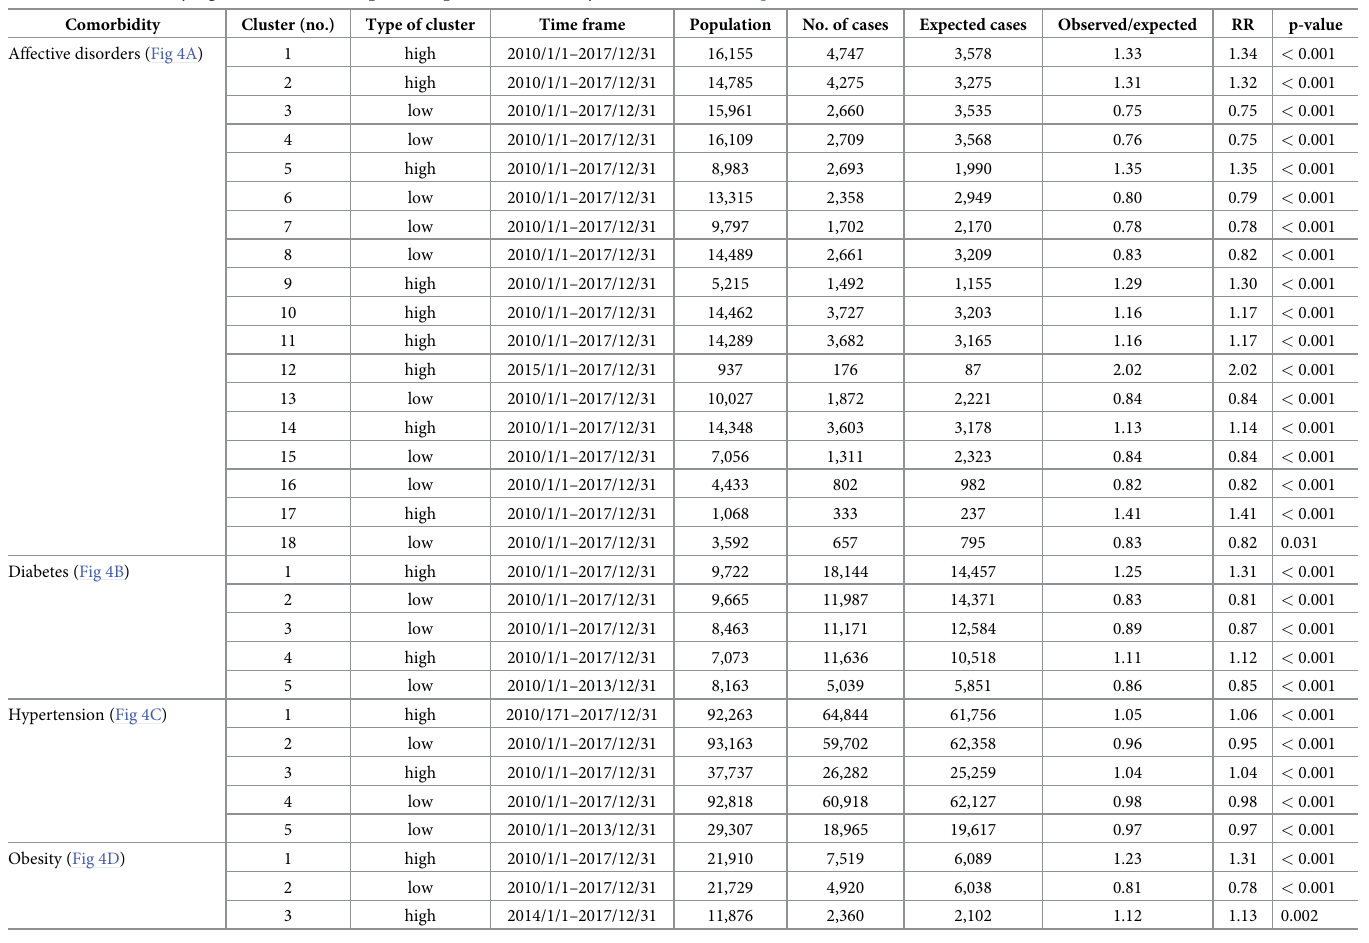
Table 3. Results (only significant clusters) spatiotemporal cluster analyses in addition to Fig 4A–4D. Comorbidity Cluster